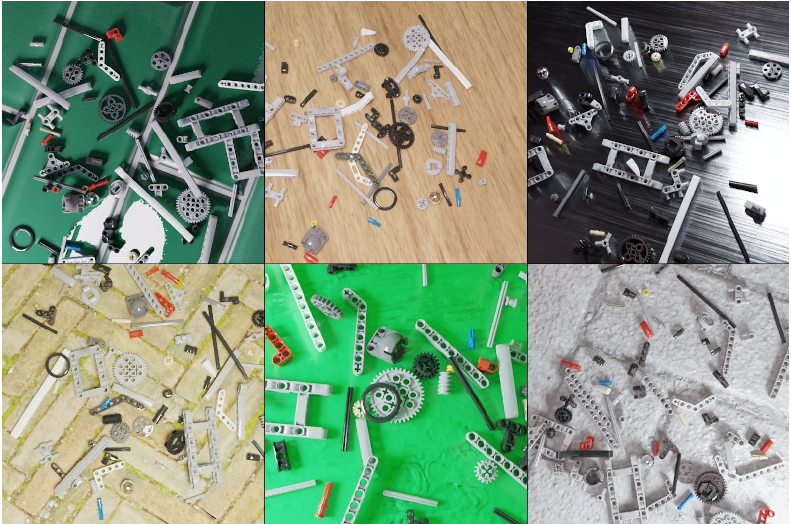
Figure 5. Synthetic dataset, showing synthetically generated images with different backgrounds and camera and light